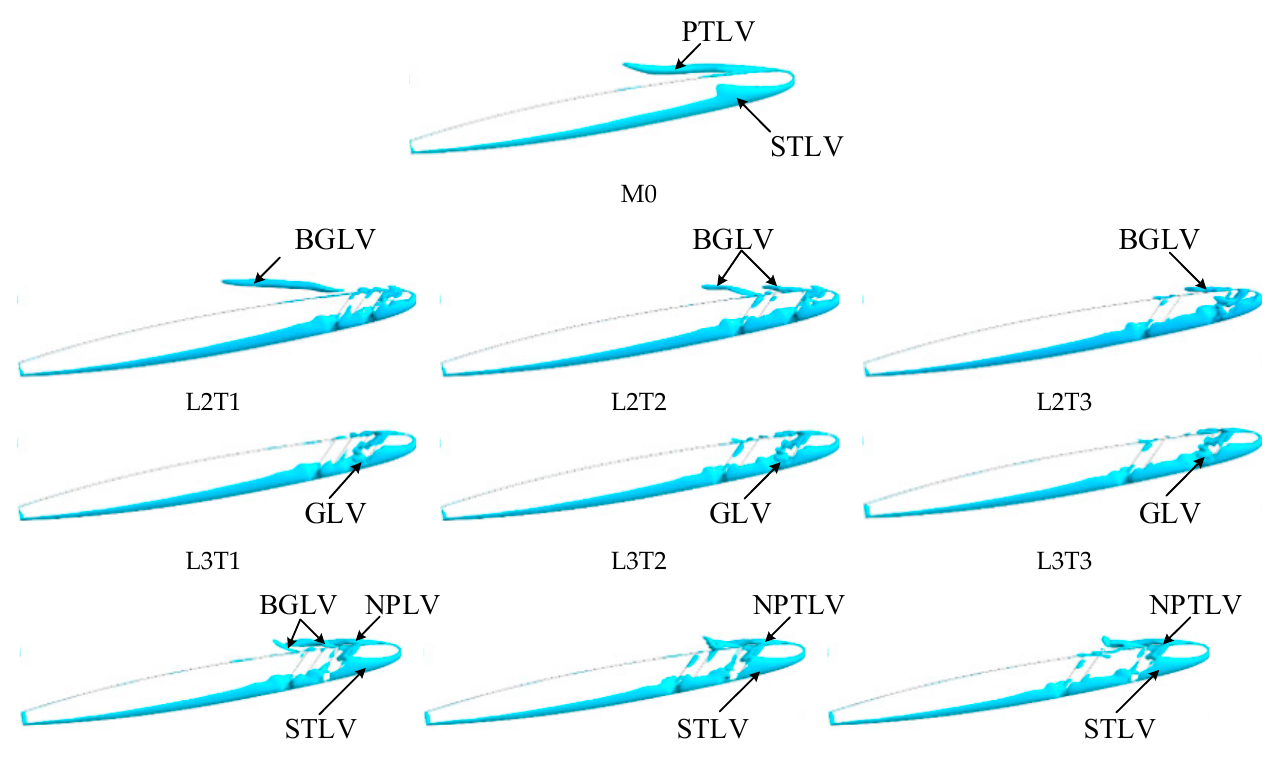
Figure 6. The vortex structure shown by Q criterion.